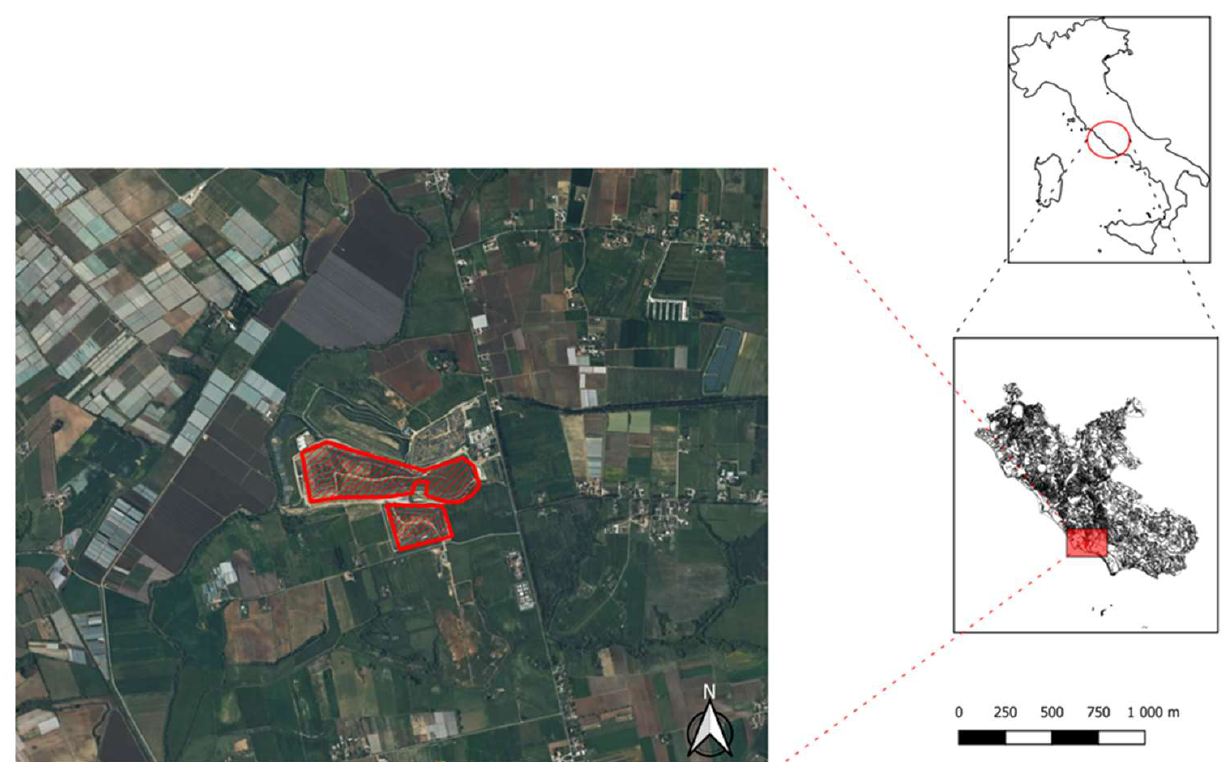
Figure 1. Borgo Montello landfill study area.